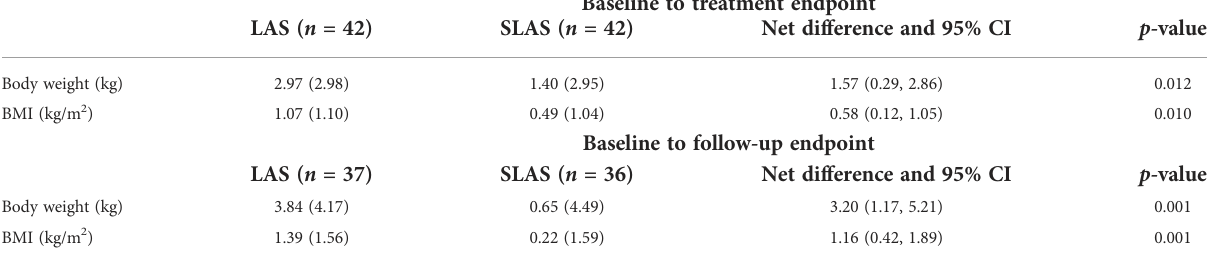
TABLE 3 Change of body weight and body mass index during the whole